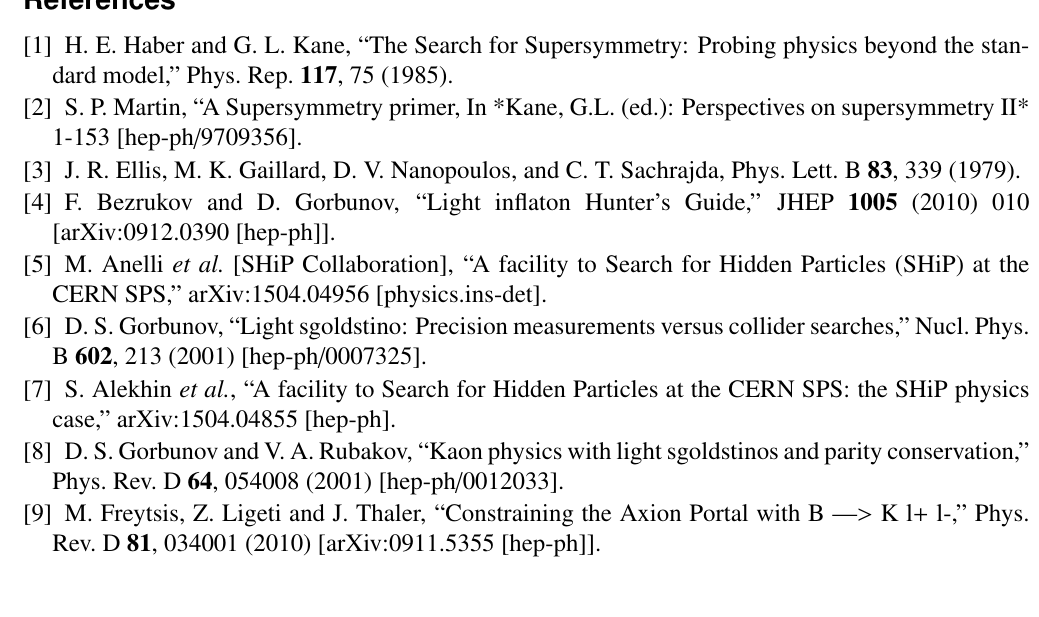
Figure 4. Pseudoscalar sgoldstino lifetime for pannel). And branchings ratios of the pseudoscalar sgoldstino (on the right